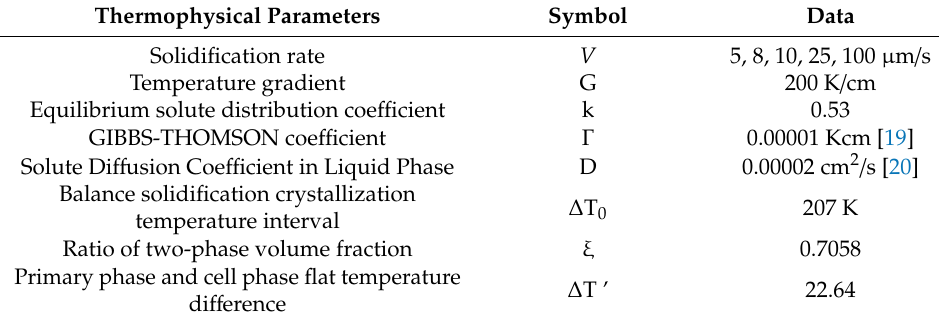
Table 1. Thermophysical parameters of a peritectic CuCe